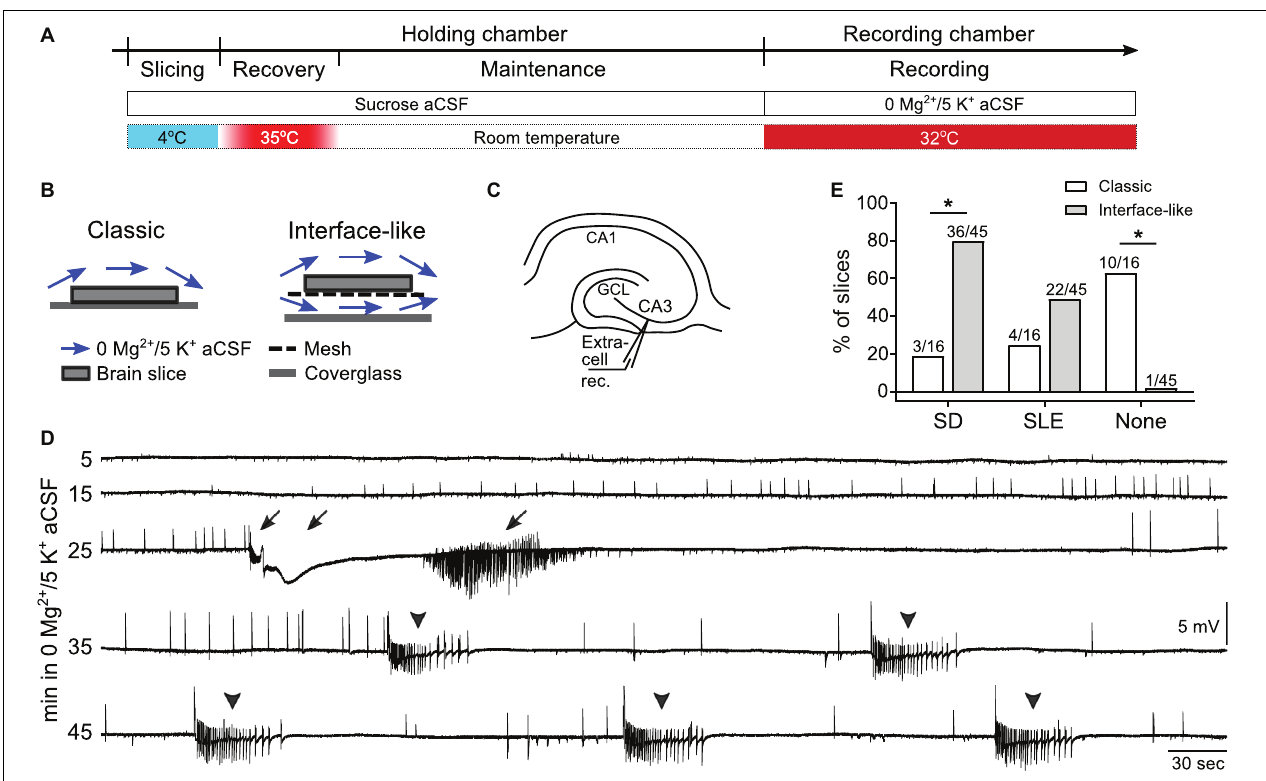
FIGURE 1 | Spreading depolarization (SD) and seizure-like events (SLEs) developed in 0 Mg 2 + /5 K + aCSF in an interface-like submerged chamber. (A) Experimental timeline. Hippocampal slices were prepared in ice-cold sucrose-based artificial cerebrospinal fluid (sucrose aCSF). Slices were incubated at 35 ◦ C for 45 min and then maintained at room temperature in sucrose aCSF before being transferred to the recording chambers for recording at 32 ◦ C. (B) Illustration of classic (single superfusion) and interface-like (dual superfusion) recording chambers. (C) Schematic of extracellular recording in CA3 of hippocampus. (D) A representative trace shows a continuous recording of extracellular activity in CA3 in 0 mM [Mg 2 + ] o /5 mM [K + ] o aCSF (0 Mg 2 + /5 K + aCSF). The slice was recorded in an interface-like recording chamber. Both SD and SLEs, and either one could precede the other. Arrows point to a single SD and its after discharges. Arrowheads point to five SLEs. (E) Percentage of SDs, SLEs, and neither event (none) that developed in classic (white bars) or interface-like (gray bars) recording chambers within the first hour of 0 Mg 2 + /5 K + aCSF exposure. Slices recorded in an interface-like recording chamber showed a higher percentage of SD than in a classic recording chamber (two-sided Fisher’s exact test, p < 0.0001 asterisk indicates p < 0.05). Nighty-eight percent of slices recorded in an interface-like chamber developed SD and/or